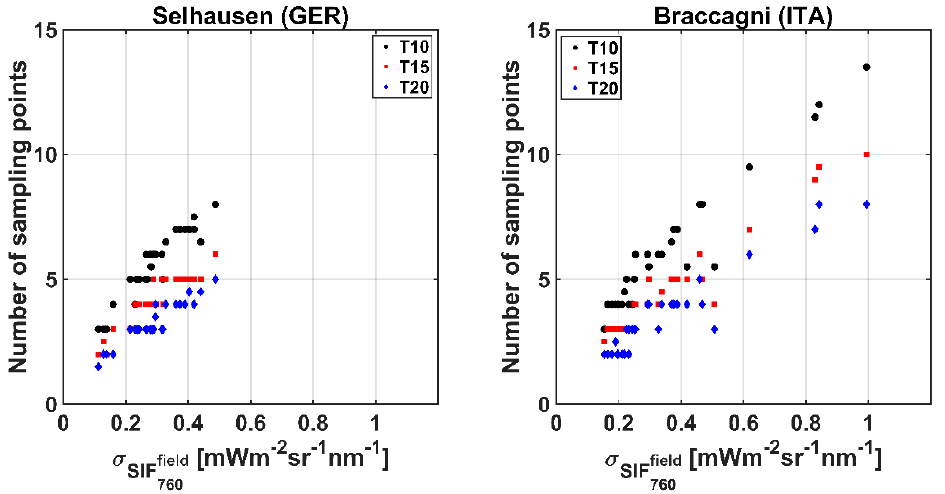
Figure 3. The 95th percentile of the number of sampling points needed to meet the three selected thresholds for the monocultural fields in Selhausen (Germany) and Braccagni (Italy) experimental sites using a random sampling approach.